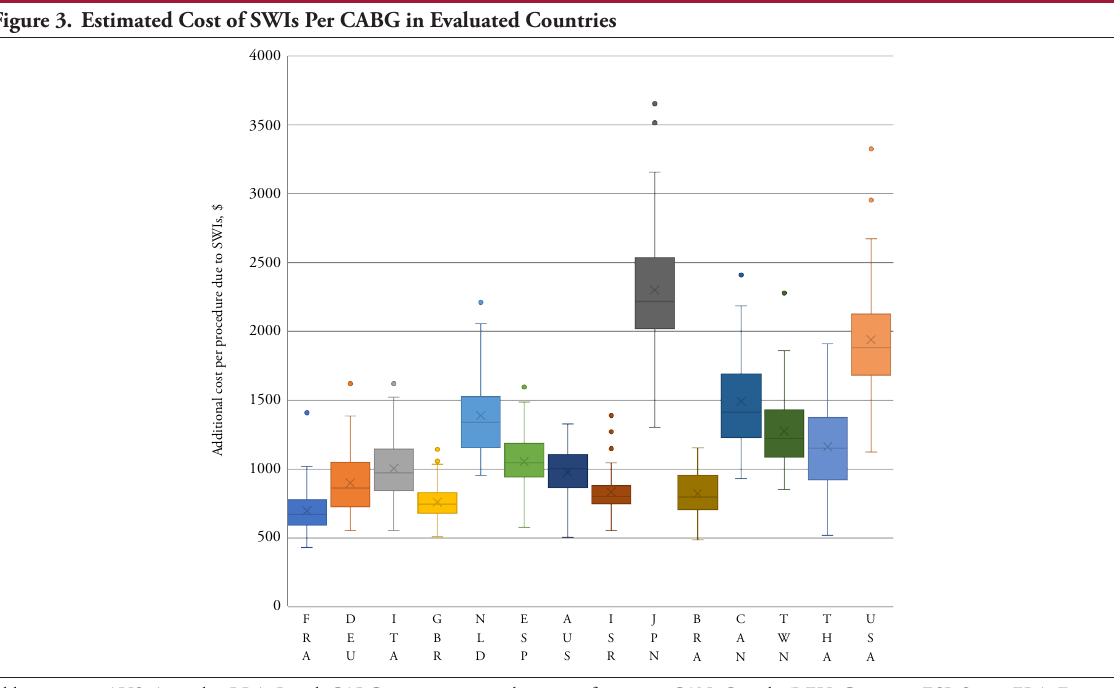
Figure 2. Prevalence of Superficial and DSWIs in Analyzed Countries FranceGermanyItalyUKNetherlandsSpainAustraliaJapanBrazilCanadaTaiwanThailandUS